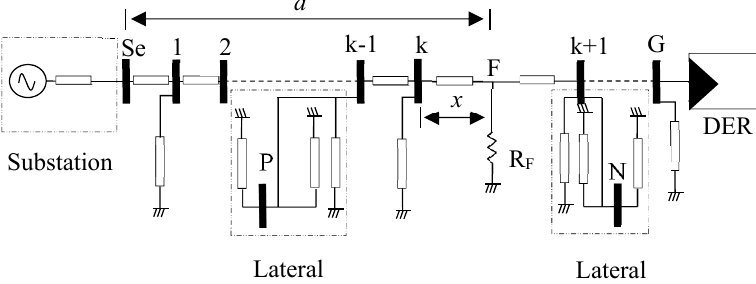
Figure 1. Power distribution system model with a fault between nodes k and k+1 . DER: distributed energy resources.